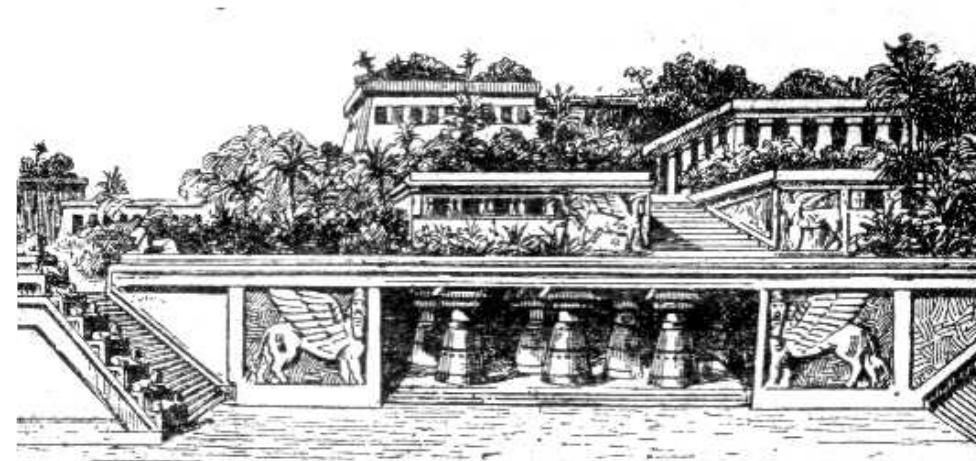
Figure 1. The Vision of Babylon Garden. 1912. https://pl.wikipedia.org/wiki/Plik:Ogrody_semiramidy.jpgimage (accessed on 16 July 2022). From book published in 1912 (Petit Larousse).